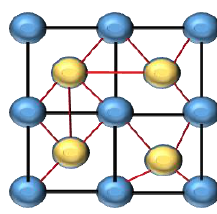
Figure 4. Example of a new superpixel in the neighborhood relationship.